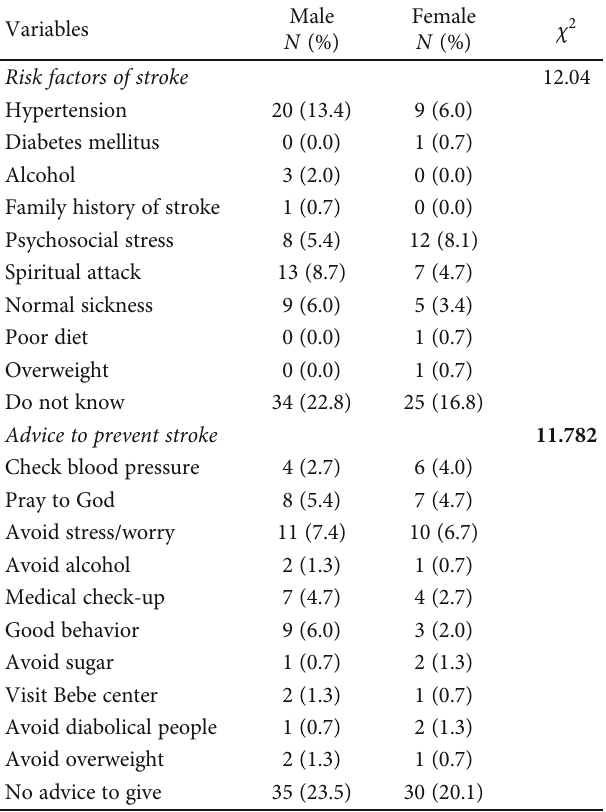
Table 3: Survivors ’ knowledge of causes of stroke, their advice for prevention, and Pearson ’ s correlation with